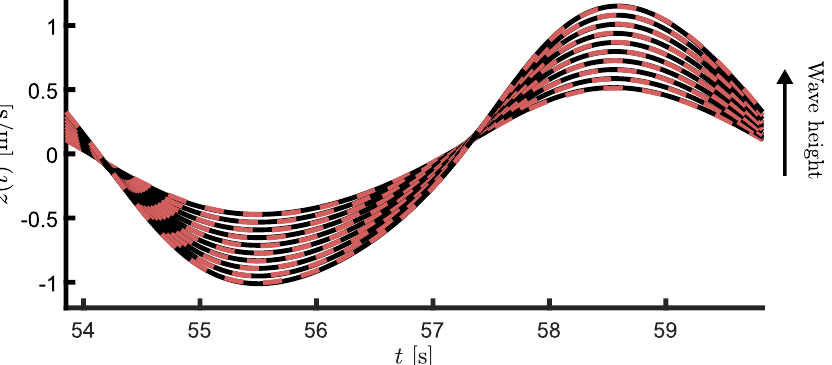
Figure 5. Target steady-state responses (solid-black), along with the data-driven approximating moment evaluated at each specific trajectory of G (dashed-red).